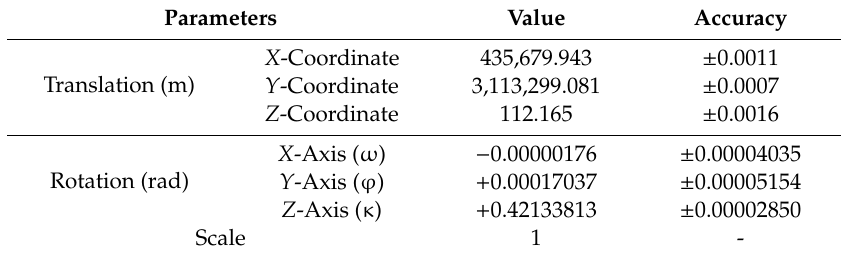
Table 2. Coordinate transformation parameters between the local and reference system and associated precision values.